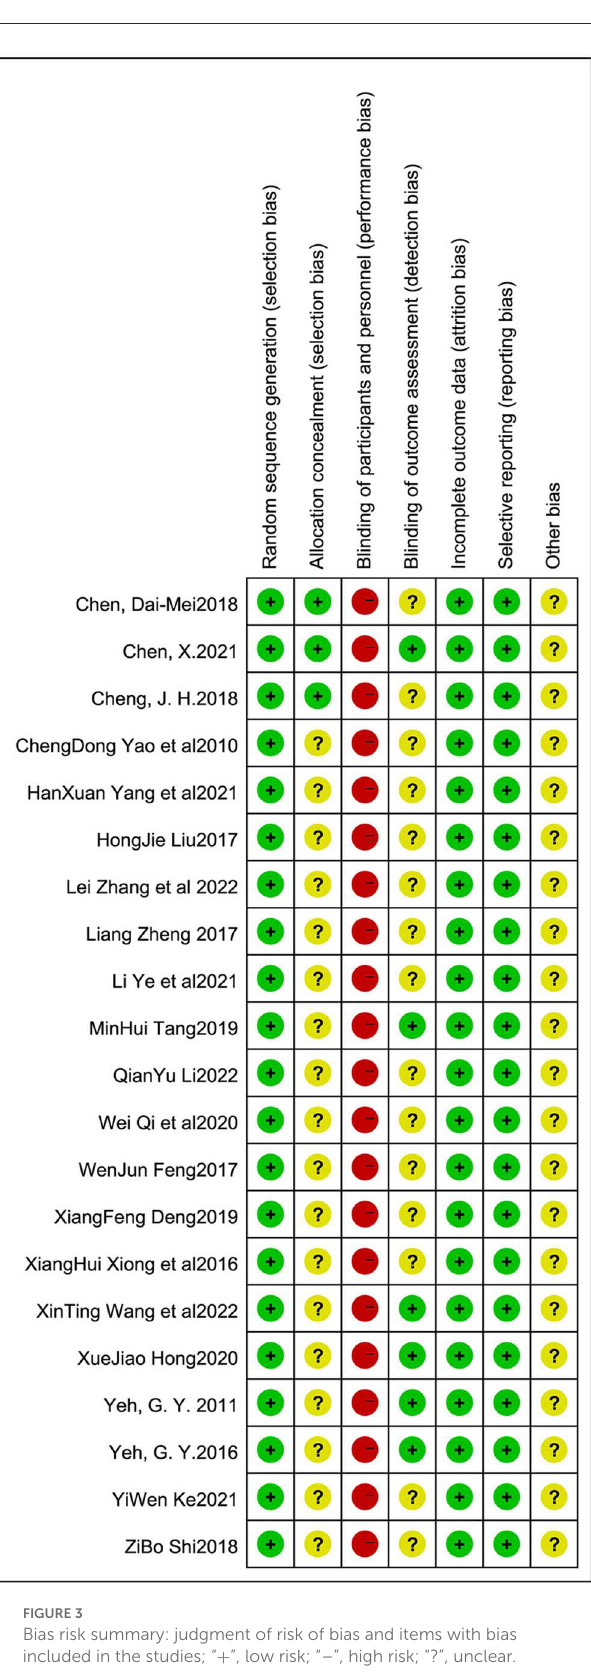
FIGURE3 Bias risk summary: judgment of risk of bias and items with bias included in the studies; “ + ”, low risk; “–”, high risk; “?”,